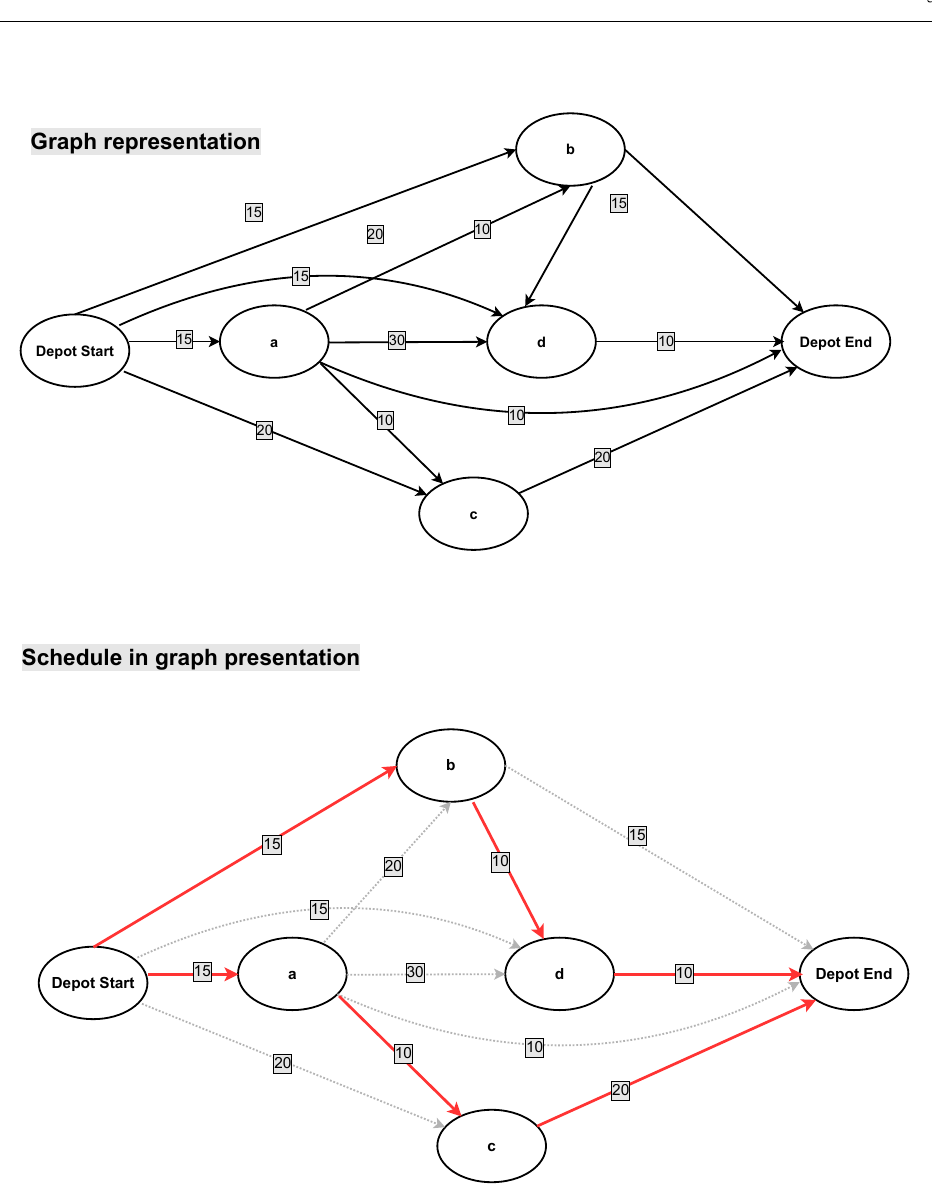
Figure 1. Illustration of the conversion of a timetable with known distances between origins and destinations between trips. The directed graph ( middle ) has a node for each trip and edges only connect trips that can be sequentially done. The set of red edges ( bottom ) is a schedule of EBs. It contains the two buses with schedules ( Depot , a , c , Depot ) and ( Depot , b , d , Depot )